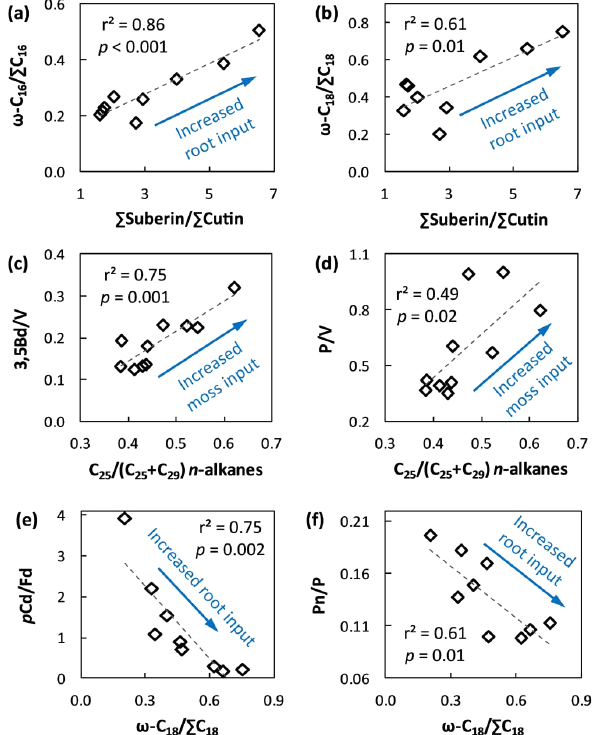
Figure 4. Correlations between the biomarker-based OC source pa- rameters in the pan-Arctic sediments. Blue arrows indicate direc- tion of change in the parameters with increased inputs of roots or mosses. See Table 3 for abbreviations and specific